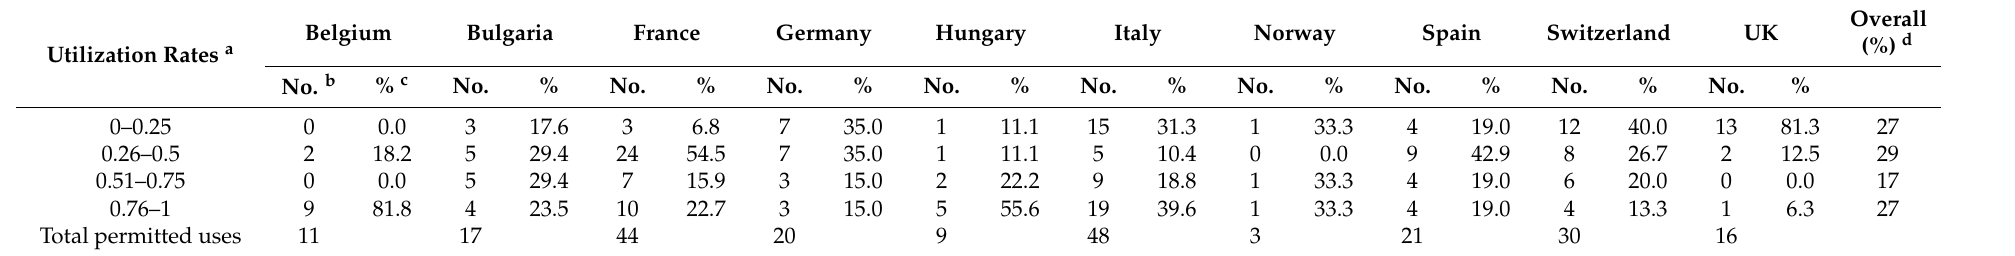
Table 3. Overview on copper-utilization rates in organic farming in 12 selected European